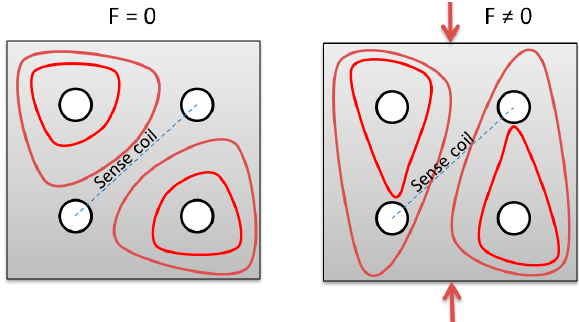
Figure 1. Pressductor operating principle (red lines—magnetic flux lines). Adapted from [1].